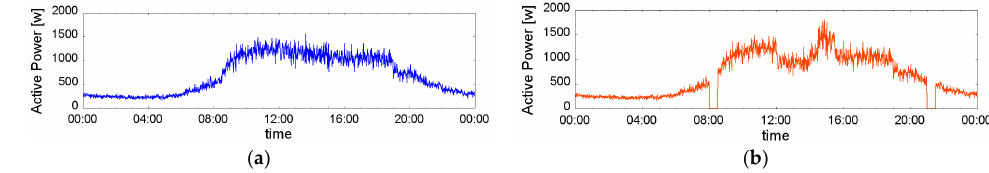
Figure 5. Load curve recorded during an entire day at a node with missing readings: ( a ) without outliers ( b ) with outliers.